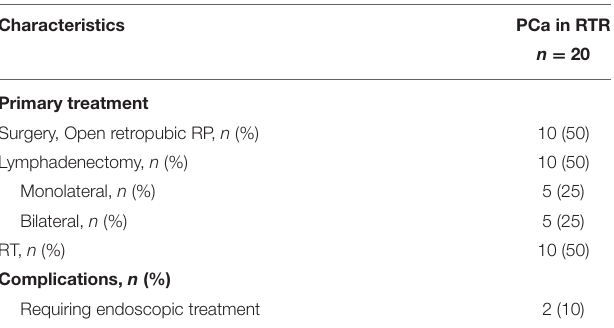
TABLE 2 | Characteristics of the primary